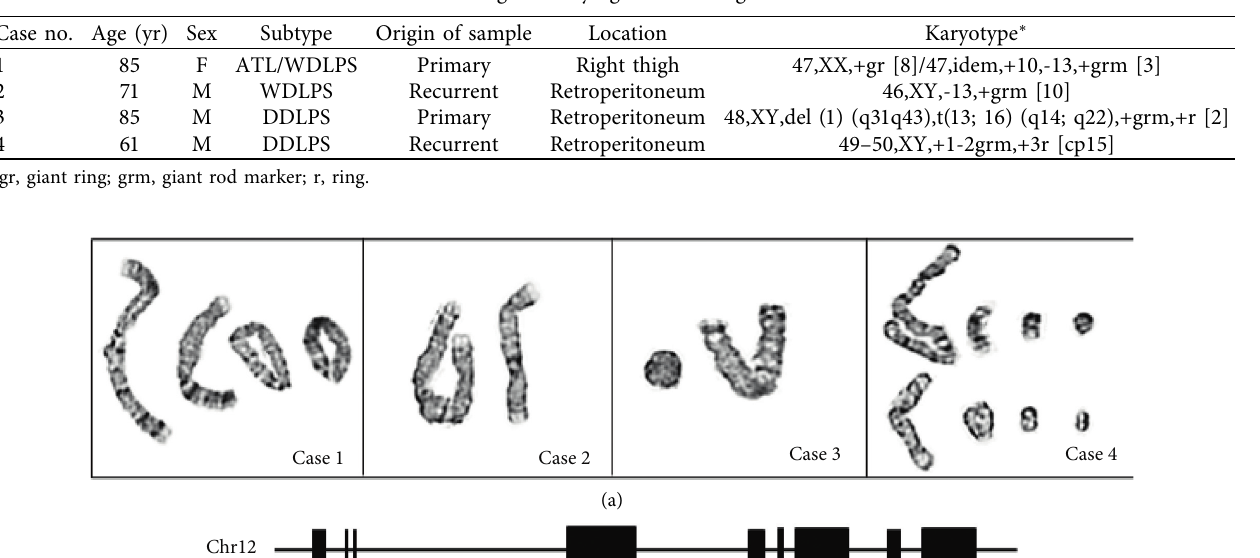
Table 1: Pathologic and cytogenetic findings in four cases.